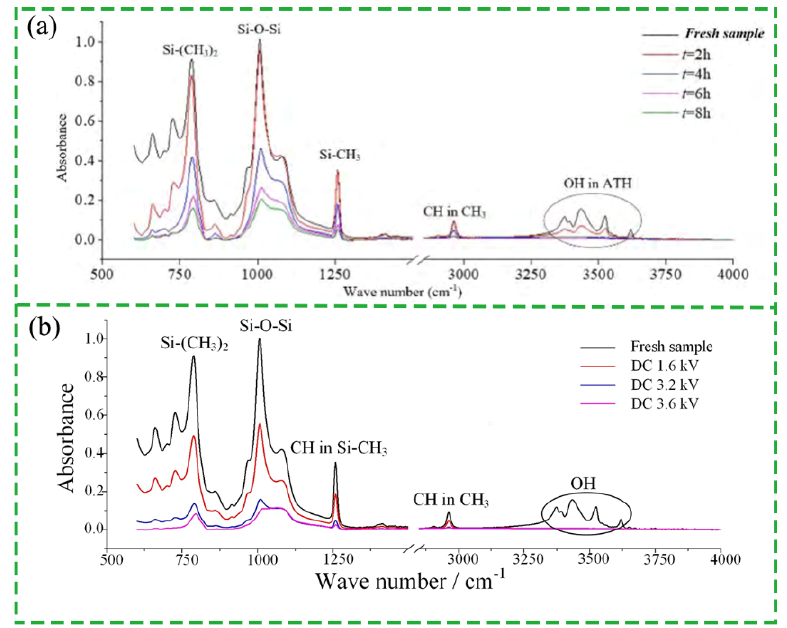
Figure 10. FTIR spectra. ( a ) FTIR spectra of composite insulators operated for 2 h, 4 h, 6 h and 8 h in a salt fog environment. ( b ) FTIR spectra of DC 1.6 kV, 3.2 kV and 3.6 kV composite insulators in a salt fog environment.